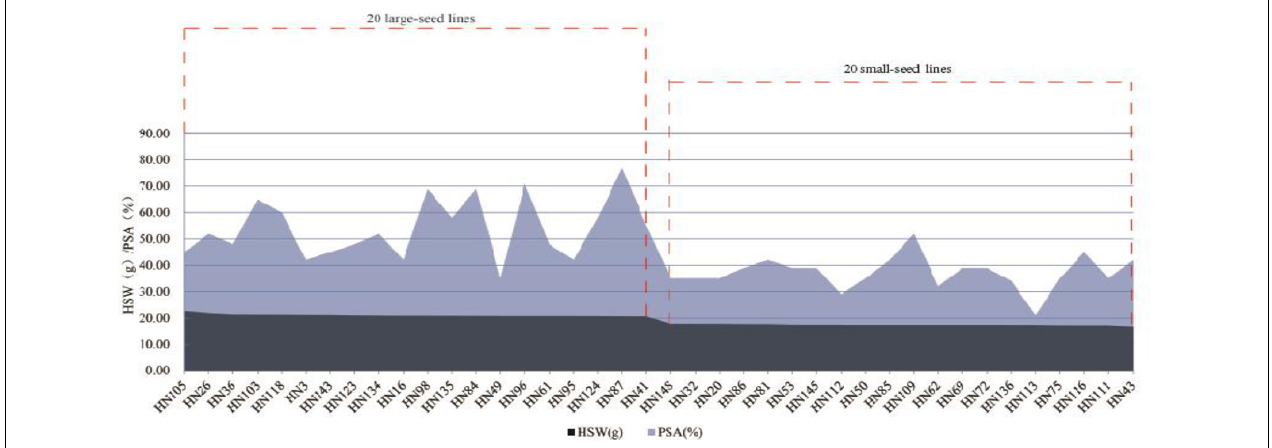
FIGURE 5 | Distribution of superior allele percentages and the hundred-seed weight in the 40 smaller and larger-seed lines.